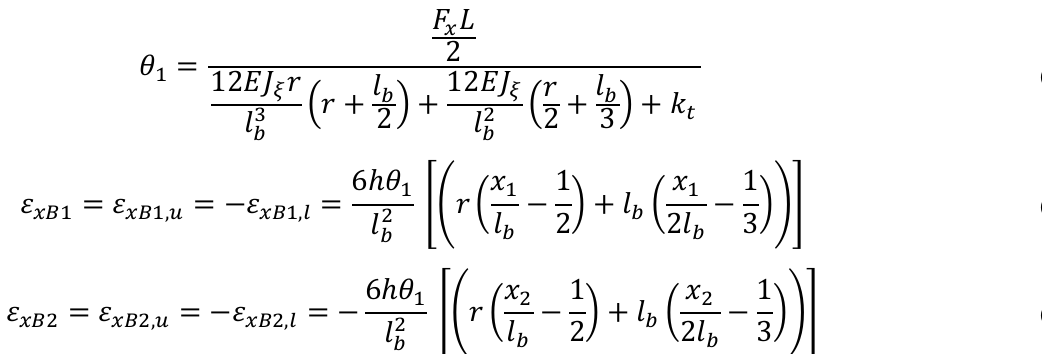
L is applied along the y- axis is x